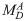
Key parameters governing CRP function.(A) Within the MWC and KNF models, each CRP subunit can assume either an active or an inactive conformation with a free energy difference ϵ between the two states. cAMP can bind to CRP (with a dissociation constant MDA in the active state and MDI in the inactive state) and promotes the active state (MDA<MDI in the MWC model; MDI→∞ in the KNF model). Active CRP has a higher affinity for the operator (LDA) than the inactive state (LDI). When CRP is bound to DNA, it promotes RNA polymerase binding through an interaction energy ϵP, thereby enhancing gene expression. (B) Lanfranco et al. constructed a single-chain CRP molecule whose two subunits could be mutated independently. All possible dimers are shown using five mutant subunits: wild type (WT), D (D53H), S (S62F), G (G141Q), and L (L148R). Lanfranco et al. constructed the six mutants comprised of WT, D, and S (black and pink boxes) and analyzed each mutant independently.